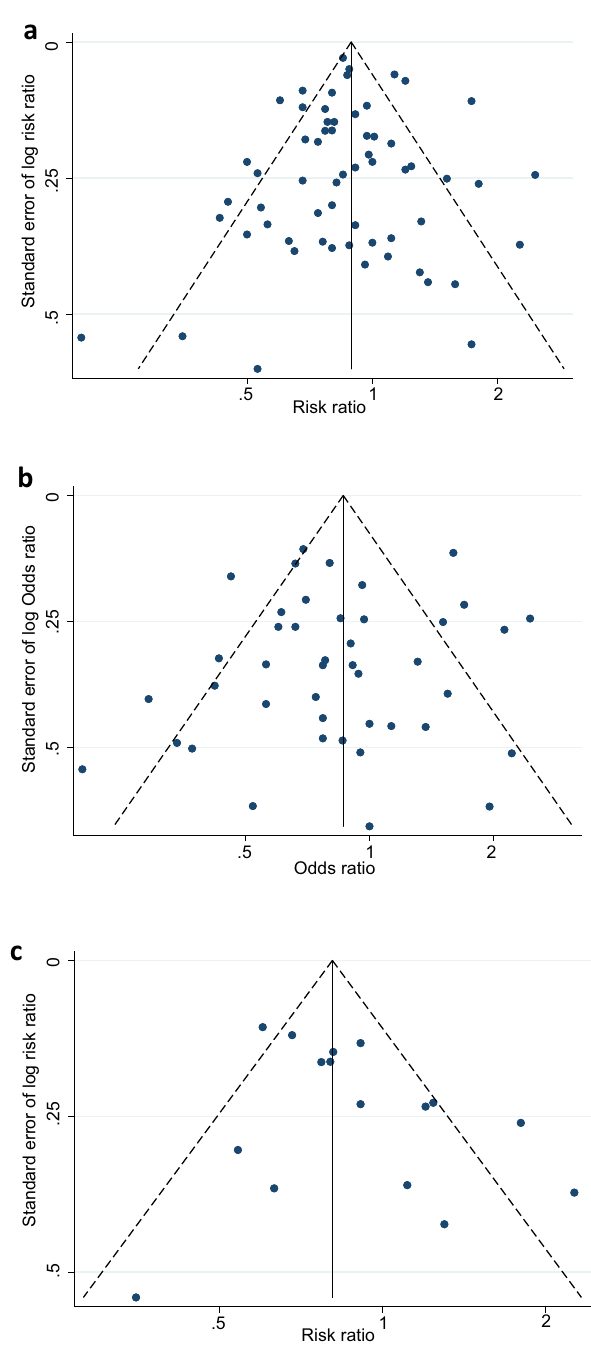
Figure 6. Funnel plots demonstrating the potential presence of publication bias in studies reporting ( a ) composite outcome of any STIs/BV, ( b ) prevalent outcome of any STIs/BV, and ( c ) incident outcome of any STIs/BV. The scatter represents single